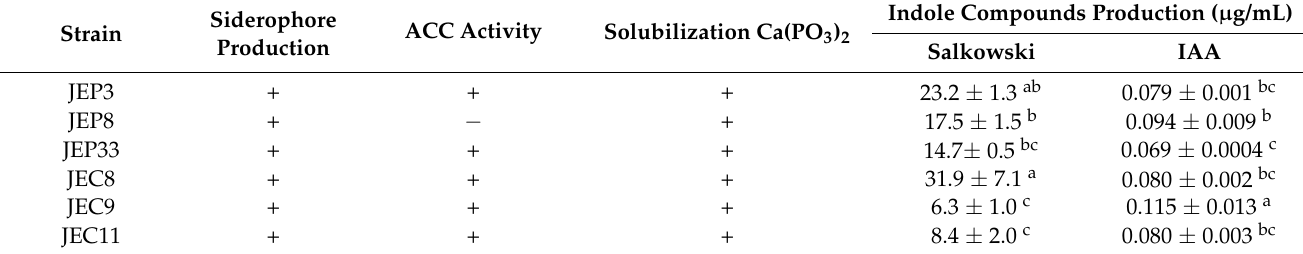
Table 3. Characteristics of endophytic bacteria from T. latifolia roots.